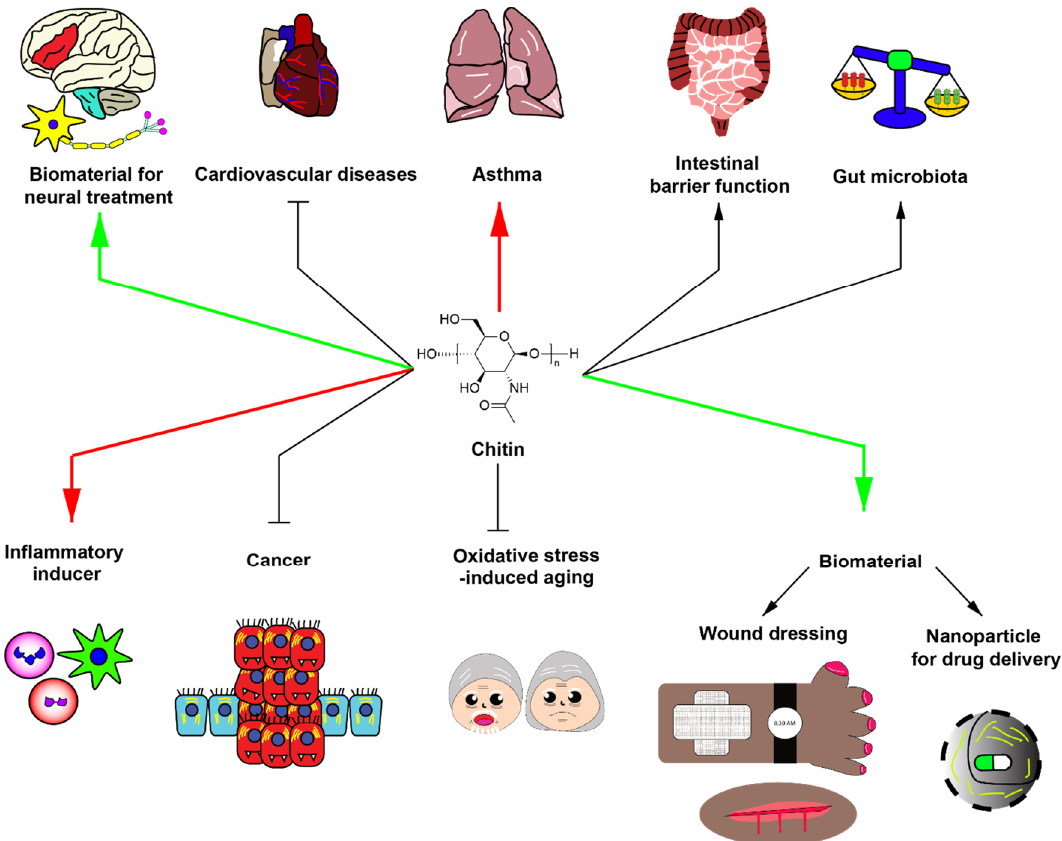
Figure 1. Potential roles of chitin in biomedical applications. Green arrows indicate potential beneficial applications of chitin with strong evidence. Red arrows demonstrate potential detrimental effect of chitin with strong evidence. Black arrows delineate the potential effects of chitin with slight evidence. Chitin has been generally utilized as biomaterials for neural treatment, wound dressing and nanoparticle component for drug delivery. In addition, chitin has been used for improving intestinal barrier function, increasing beneficial gut microbiota, partially inhibiting cardiovascular diseases, inhibiting cancer growth, and inhibiting oxidative stress-induced aging. However, chitin may have detrimental effects. For instance, chitin exposure can induce asthma and acts as an inflammatory inducer.